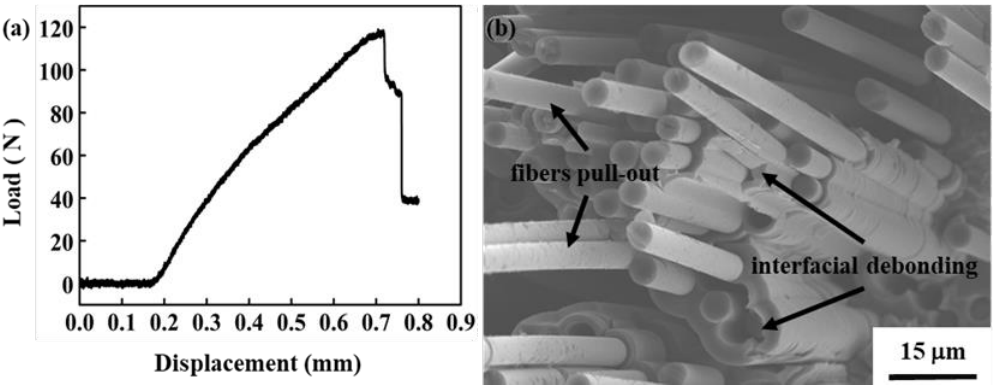
Figure 8. ( a ) Load–displacement curve of the ZrB 2 -composites; ( b ) microstructure of fracture surface.